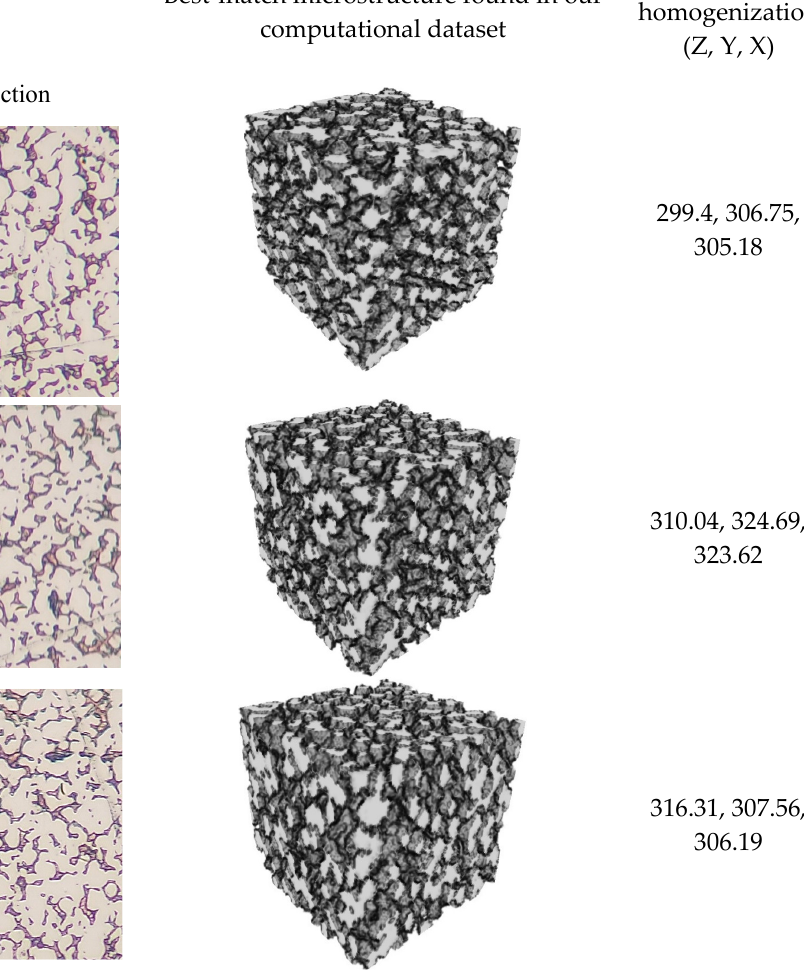
computational microstructure similar to the given cut-section images of the